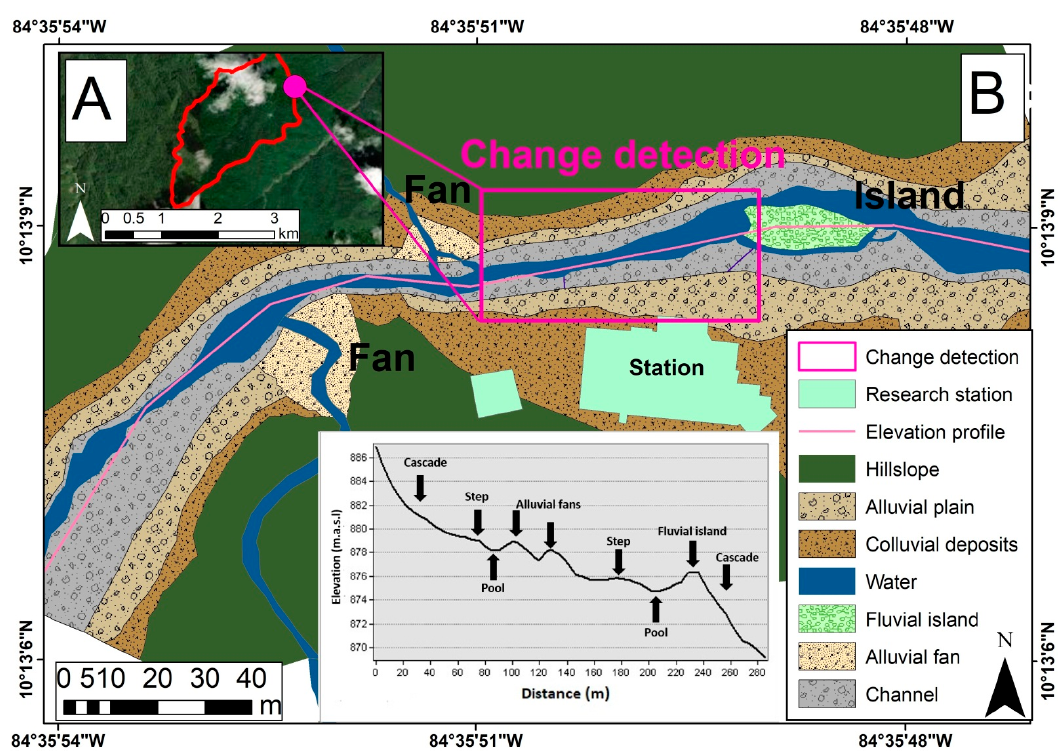
Figure 6. High-resolution fluvial geomorphology of a reach of the San Lorencito River. ( A ) Location of the survey site: the purple dot indicates the change detection location within the San Lorencito catchment, performed by the UAV surveying. ( B ) Geomorphological mapping of a river reach: the survey shows with accuracy the elevation and slope changes within the channel, allowing the identification of step-pool sections and cascades. The purple rectangle indicates the change detection within the San Lorencito river reach.